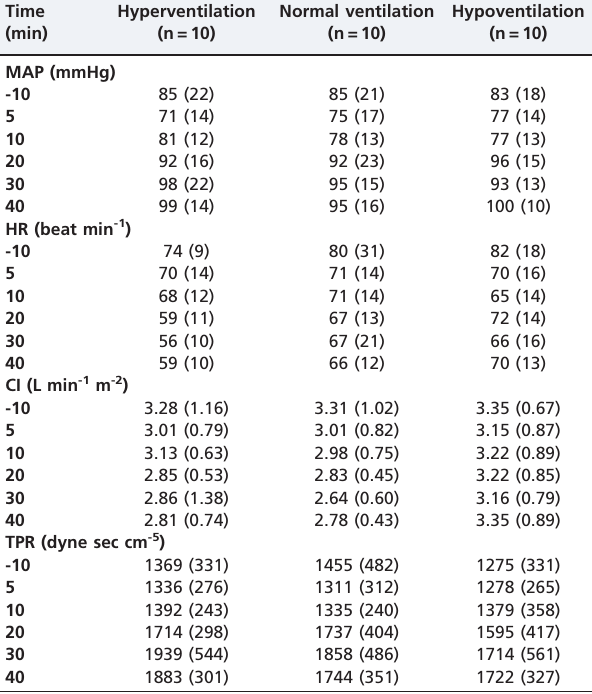
Table 2 - Hemodynamic variables for the three ventilation groups at -10 (10 minutes before the start of the study), 5, 10, 20, 30, and 40 minutes following desflurane administration.